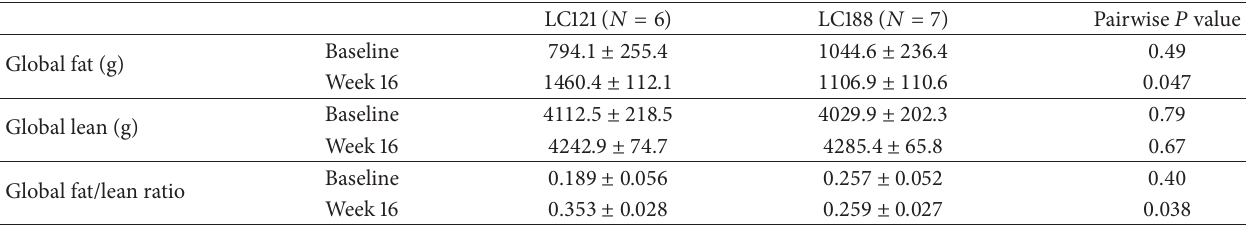
Table 2: Mean ( ± SEM) absolute or global fat (g), lean (g), and fat/lean ratio in adult cats fed LC121 or LC188 supplemented diets modified ad libitum receiving 120% of their estimated daily energy requirement.